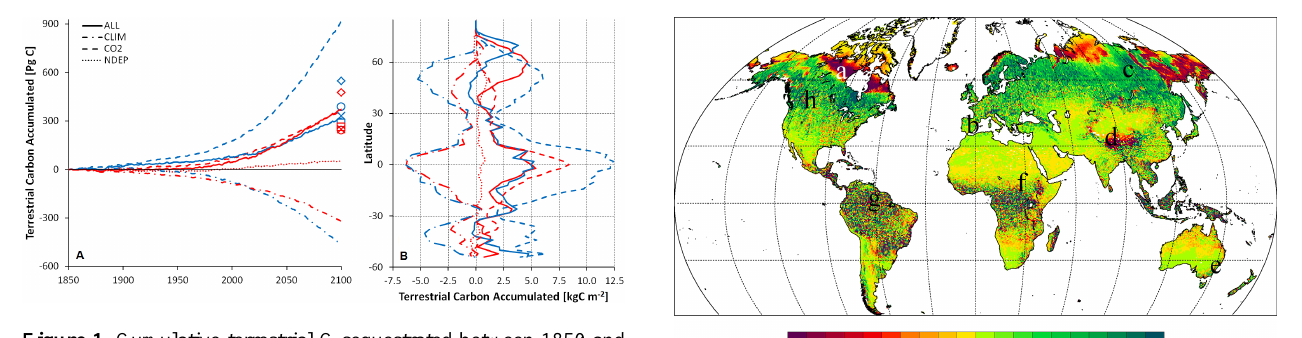
Figure 1. Cumulative terrestrial C sequestrated between 1850 and 2100 (a) simulated with historical and future change in climate (CLIM), atmospheric [CO 2 ] (CO2), N deposition (NDEP) alone, Figure 2. Simulated terrestrial C sequestration differences between and all together (ALL). Other model results are for TEM (X), O- the C-only and C–N version for the 21st century (calculated as C–N ) . Latitudinal accumulated ter- CN (O), FUN ( (cid:3) ), and JSBACH ( total pool change for 1990–2000 to 2090–2100 subtracted by C- restrial C sequestration between 2000 and 2100 (b) . Blue lines are only total pool change for 1990–2000 to 2090–2100). Negative val- (cid:51) C-only version and red lines are C–N version. ues indicating a larger cumulative uptake for the C-only version than for the C–N version. Letters a–h indicate regions detailed in Figs. 3 and